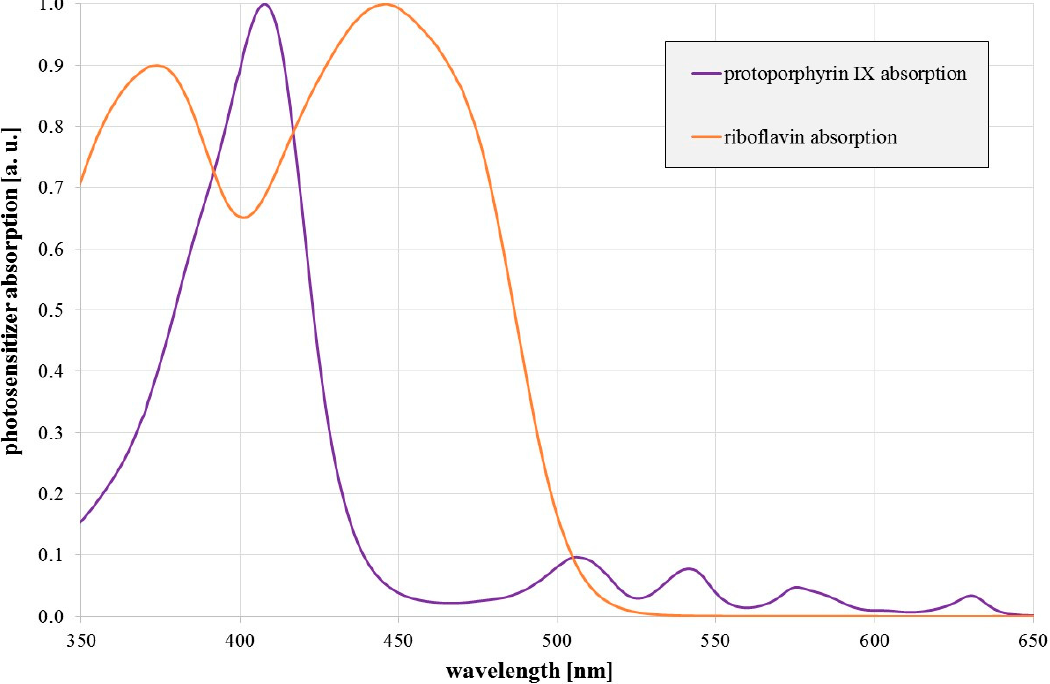
Figure 1. Relative absorption of protoporphyrin IX (in DMSO) and riboflavin (in H 2 O) as a function of wavelength.